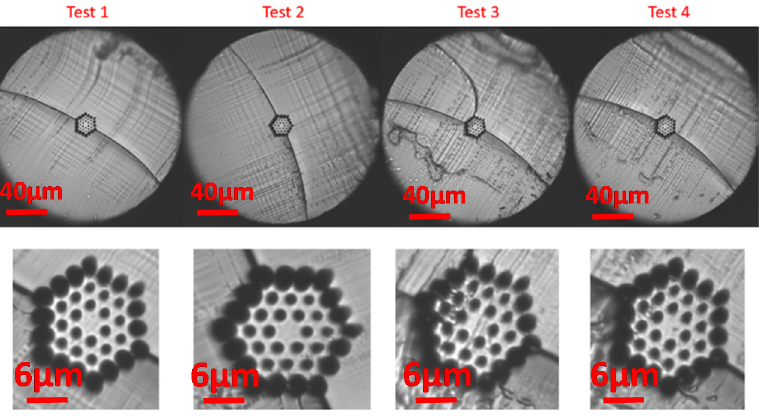
Figure 9. mPOF fiber ends using the same blade surface. Up to four fiber cleavings with satisfactory results can be obtained. Blade temperature was 60 °C at 0.5 mm/s of blade cutting speed.